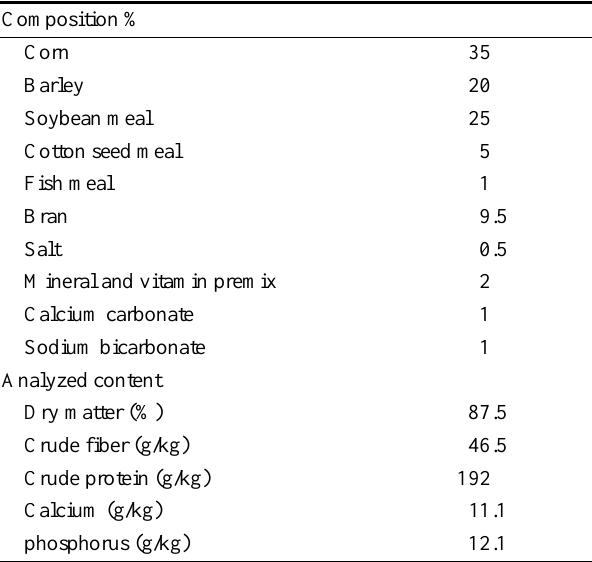
Table 1. The composition and the analyzed nutrient content in